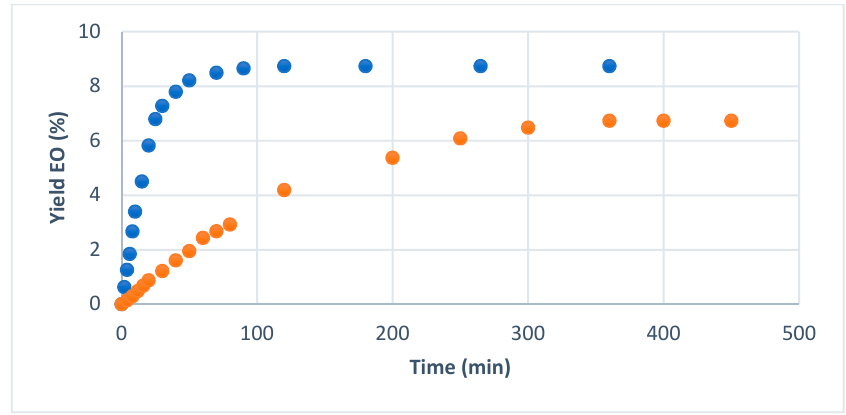
Figure 1. Chinese star anise essential oil yield per 100 g of dry matter (turbo-Clevenger hydrodistillation ).